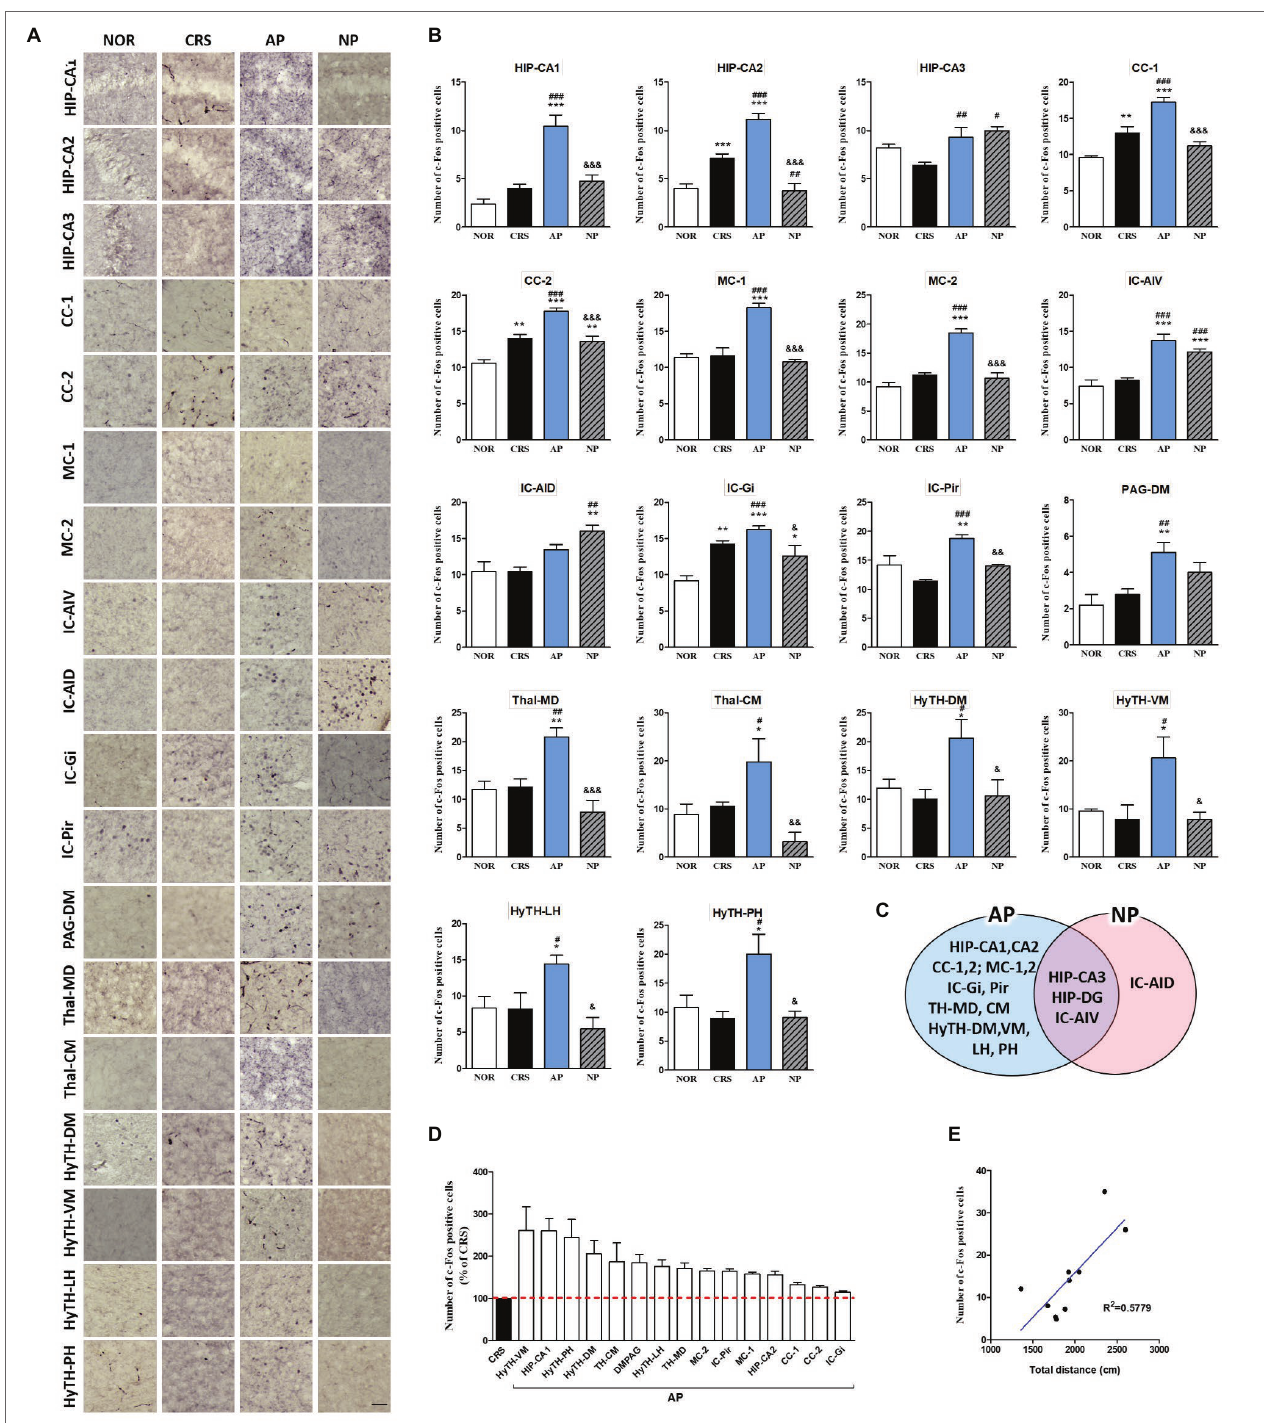
FIGURE 5 | Acupuncture treatment at AP (KI10·LR8·LU8·LR4) causes changes in c-Fos expression in the brains of 4-week CRS model mice. (A,B) Acupuncture treatment at AP (KI10·LR8·LU8·LR4) significantly increased c-Fos activation in specific regions of the cortex, hippocampus, thalamus, and hypothalamus. (C) Schematic Venn diagram represents brain areas activated only by AP, only by NP, or by both stimuli. (D) Number of c-Fos-positive cells in brain regions changed only by acupuncture treatment (% of CRS group value). (E) Correlation between the c-Fos expression of HyTH-VM and behavioral patterns in CRS, AP, and NP groups. NOR, normal; AP, CRS and acupuncture treatment at KI10·LR8·LU8·LR4; NP, CRS and acupuncture treatment at non-acupoints on the hips. * p < 0.05, ** p < 0.01, *** p < 0.001 vs. NOR. # p < 0.05, ## p < 0.01, ### p < 0.001 vs. CRS. & p < 0.05, && p < 0.01, &&& p < 0.001 vs. AP. One-way ANOVA followed by the Newman-Keuls test. Error bars indicate